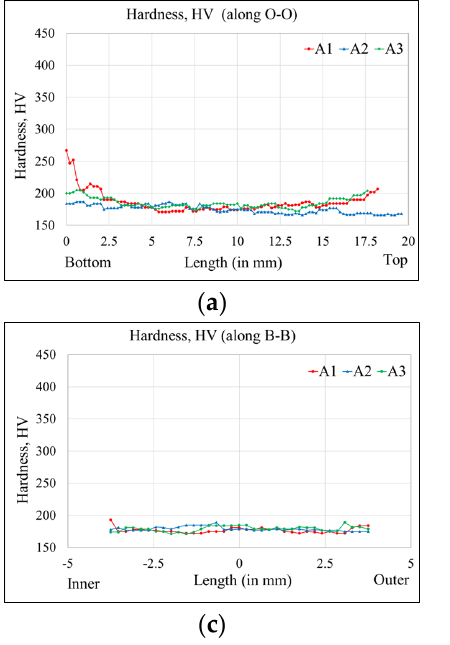
Figure 13. Hardness variation with active management along ( a ) O − O, ( b ) A − A, ( c ) B − B and ( d ) C − C.